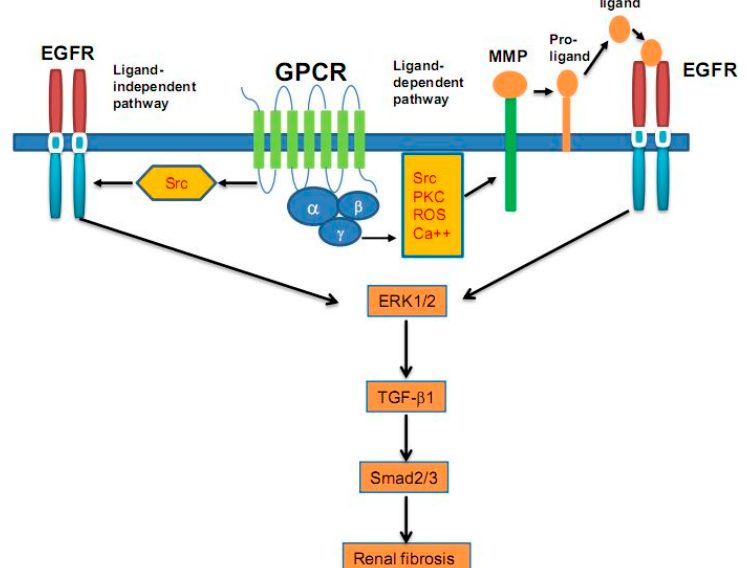
Figure 1. Signaling mechanisms of epidermal growth factor receptor (EGFR) transactivation in renal fibrosis. Upon stimulation with G protein-coupled receptor (GPCR) ligands ( i.e. , angiotension II), some intracellular events. Including activation of Src and protein kinase C (PKC), production of reactive oxygen species (ROS) and influx of calcium are initiated. Src can directly induce EGFR phosphorylation/activation via a ligand-independent mechanism. Src and other intracellular